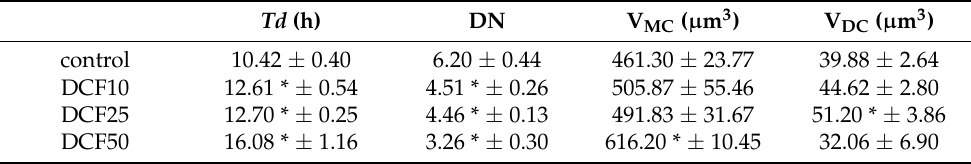
Table 1. The population doubling time ( Td ), the cells division number (DN), the mode volume of mother (V MC ) and daughter (V DC ) cells. Data are presented as means ±